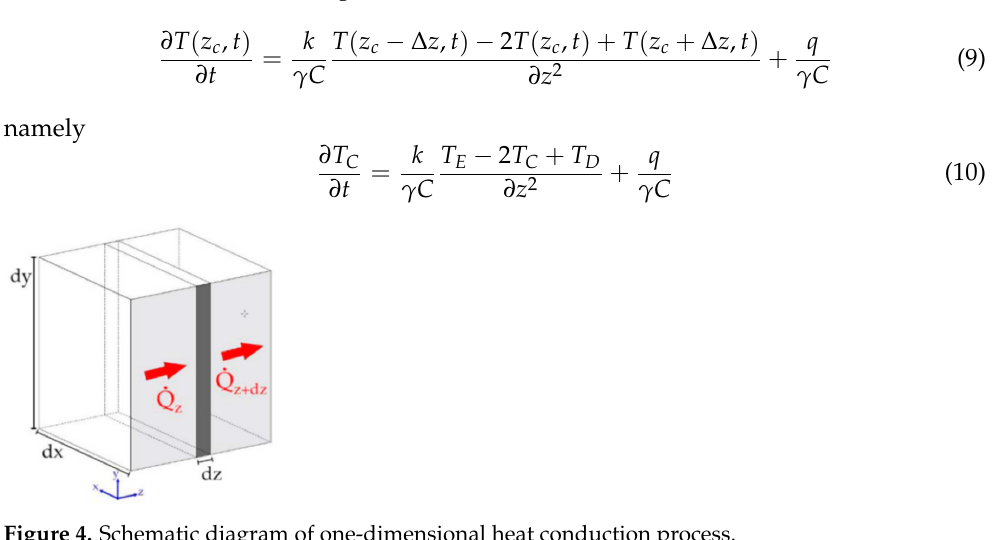
Figure 4. Schematic diagram of one-dimensional heat conduction process.